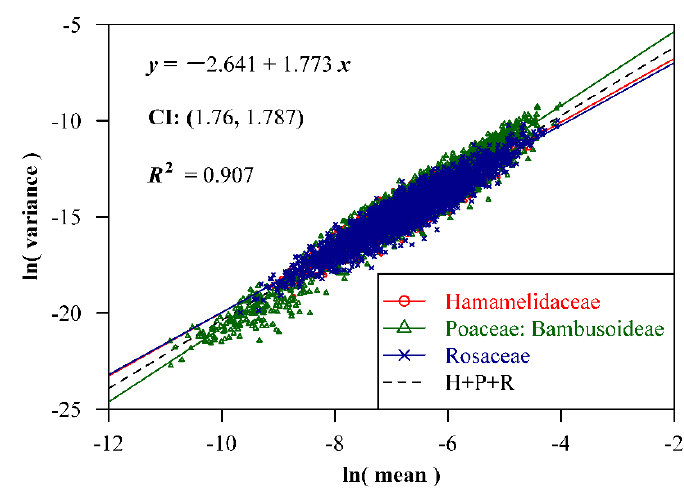
Figure 6. Comparison of the estimates of the exponent of TPL among the three classes of plants. The dashed line represents the regression line that used the pooled data of the three classes of plants. The fitted results shown at the top-left corner are for the dashed line with the pooled data.